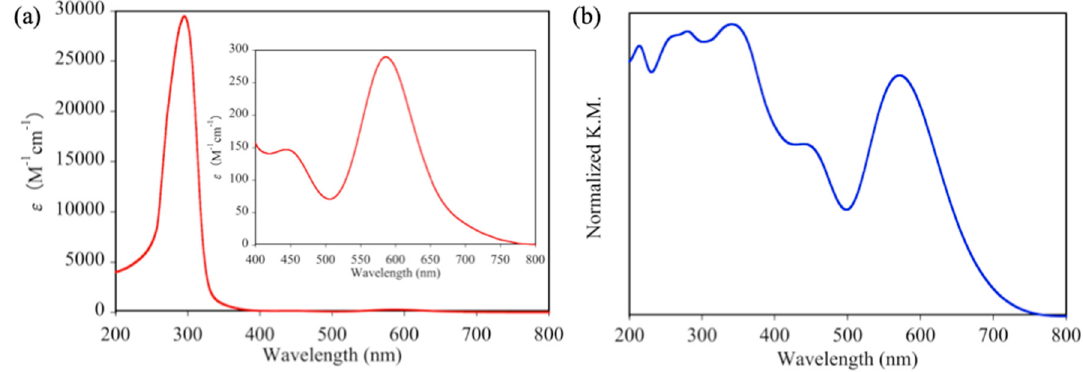
Figure 4. ( a ) Absorption spectrum of 1D in DMF and ( b ) diffuse reflectance spectrum of 1P .